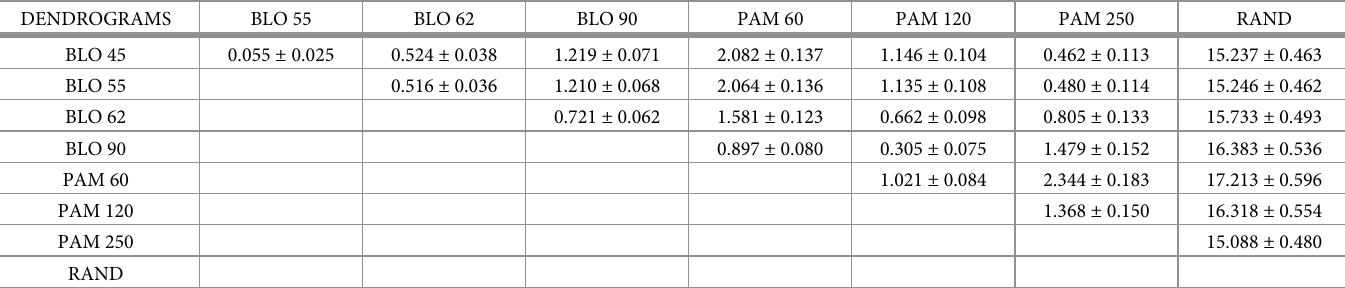
Table 1. Comparison of DENZS dendrograms built using different scoring matrices for the first ensemble (10 sets of 20 organisms in each set). DENDROGRAMS